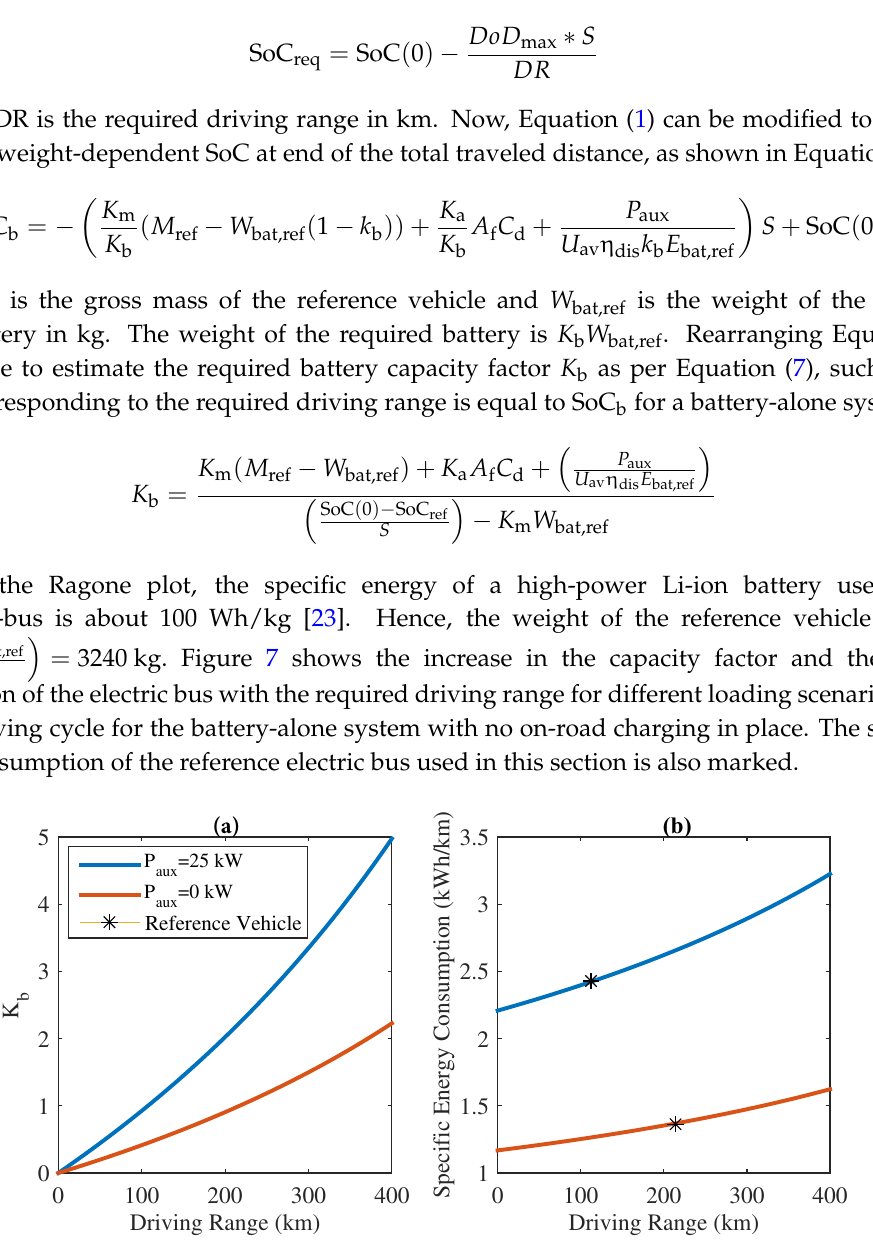
Figure 7. Impact of driving range of the vehicle for the SORT 3 driving cycle without any on-road charging on the ( a ) capacity factor K b ( b ) specific